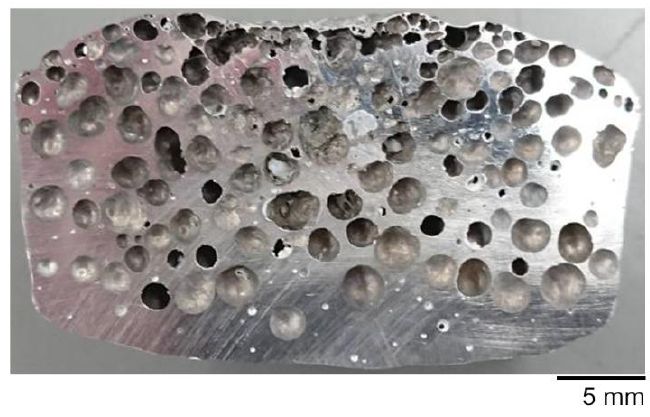
Figure 5. Cross section of the center of the aluminum alloy foam.